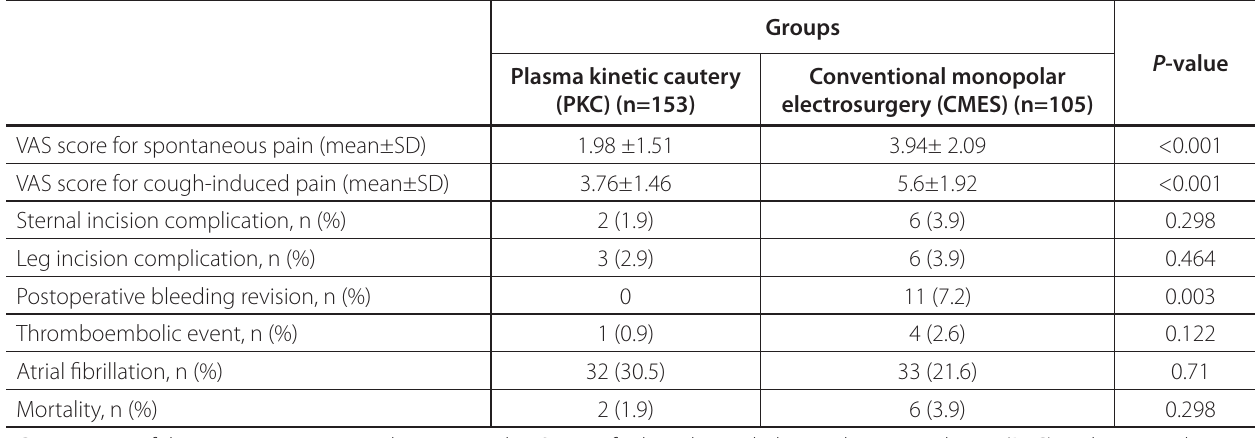
Table 3 . Postoperative data of complications and VAS score for both